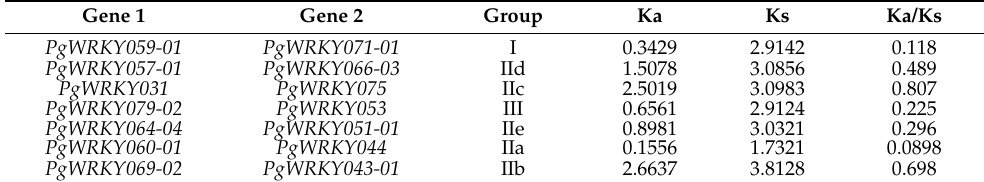
Table 2. Divergence between paralogous PgWRKY gene pairs.